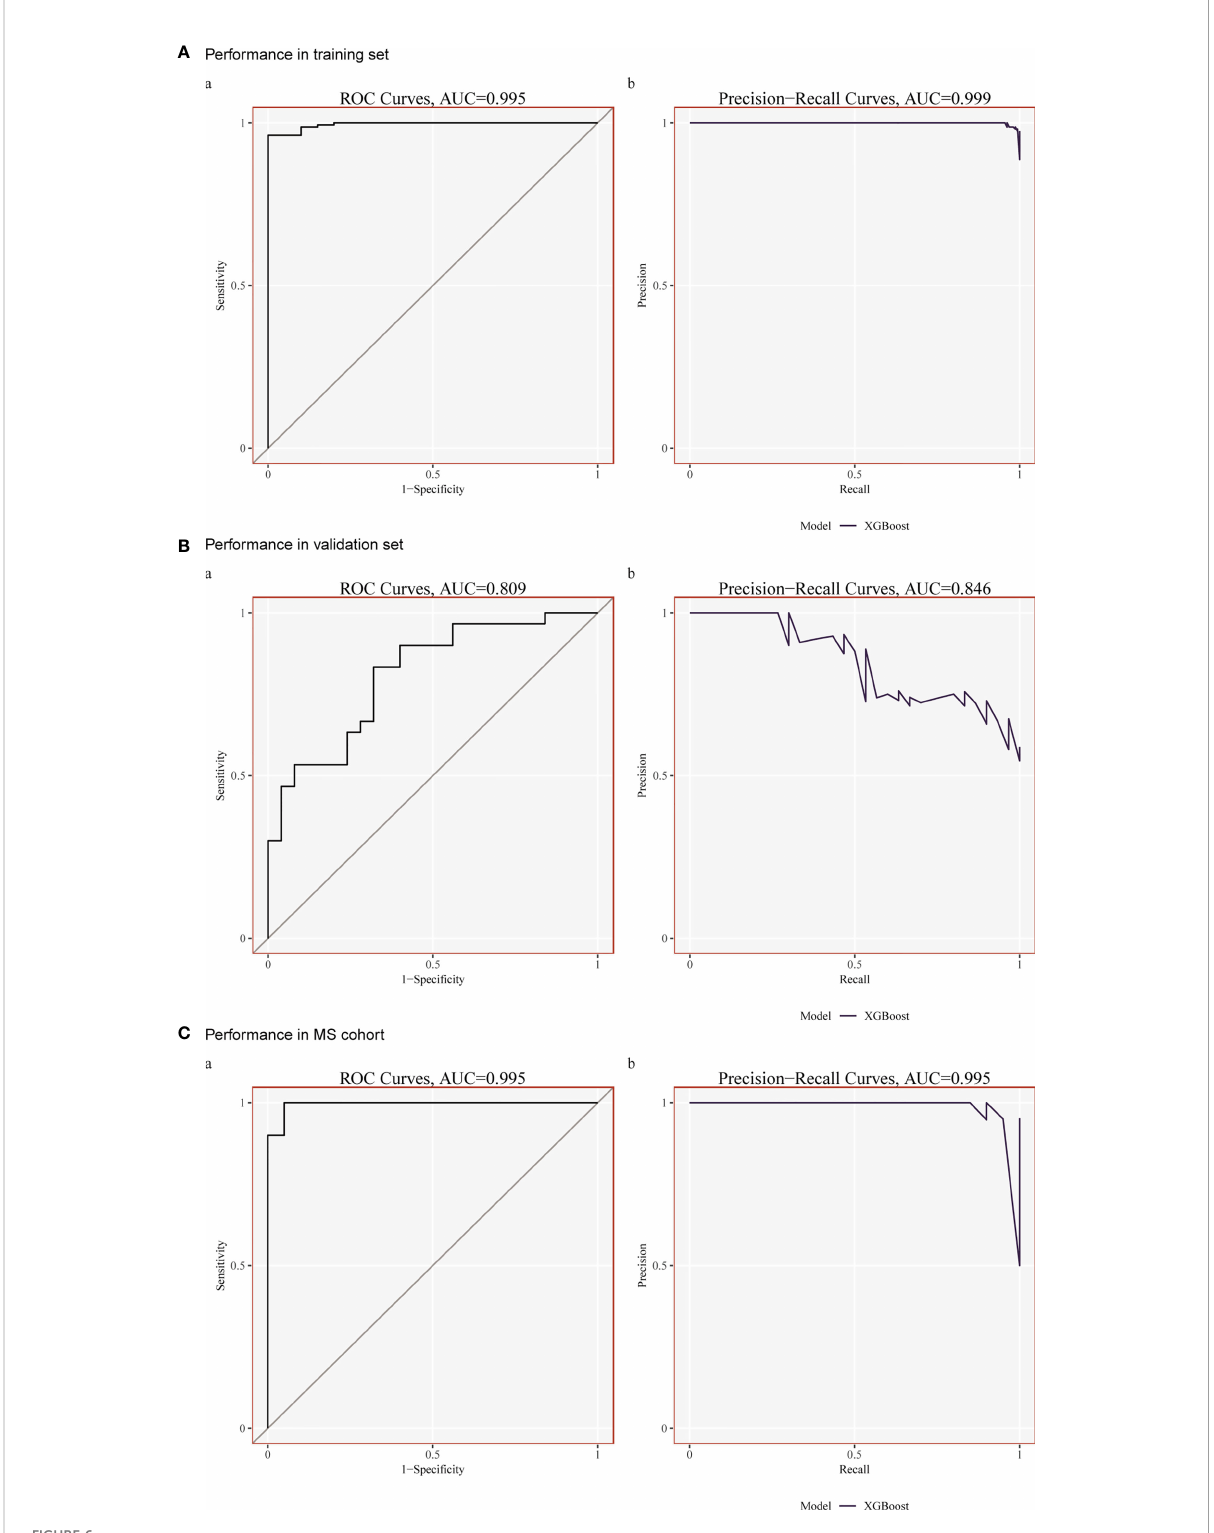
FIGURE 6 (A) Performance in the training set (GSE72326) using XGBoost. (B) Performance in the Validation set (GSE81622) using XGBoost. (C) Performance in the training set (GSE98895) using